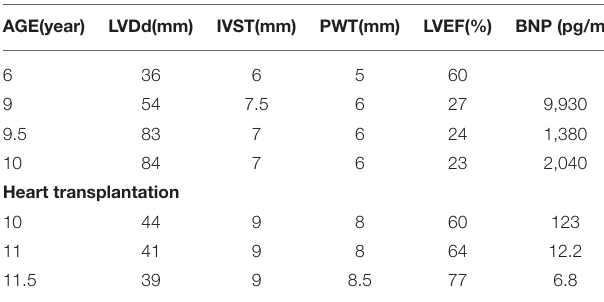
TABLE 1 | The change of echocardiogram index and BNP of case 3